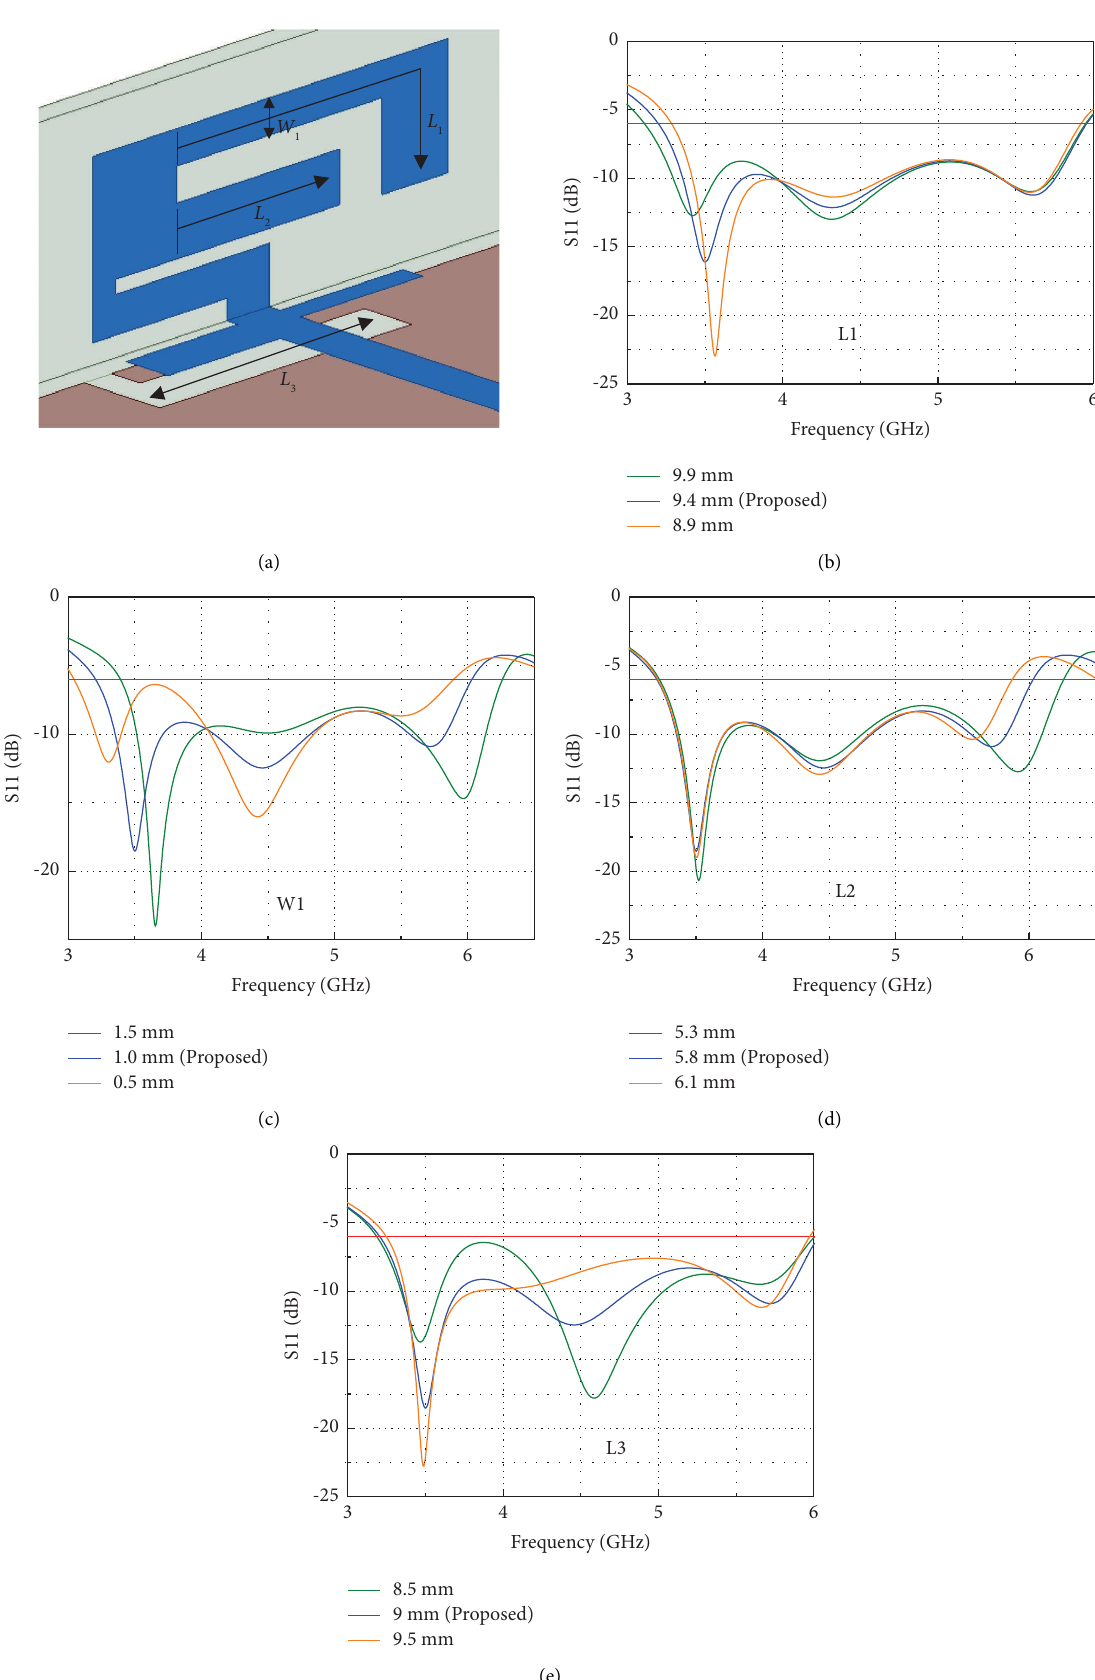
Figure 5: (a) Corresponding location of the parameters and the variety of the S parameter when tuning variables of (b) L and (e) L 3